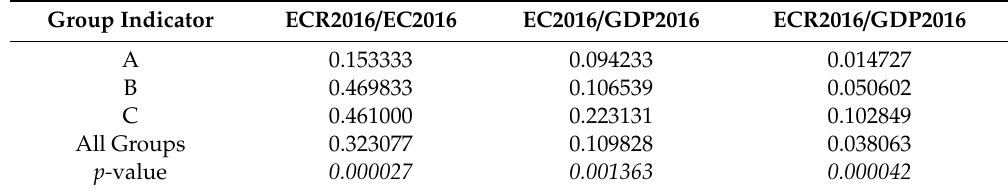
Table 8. Group averages for IRE in 2004.